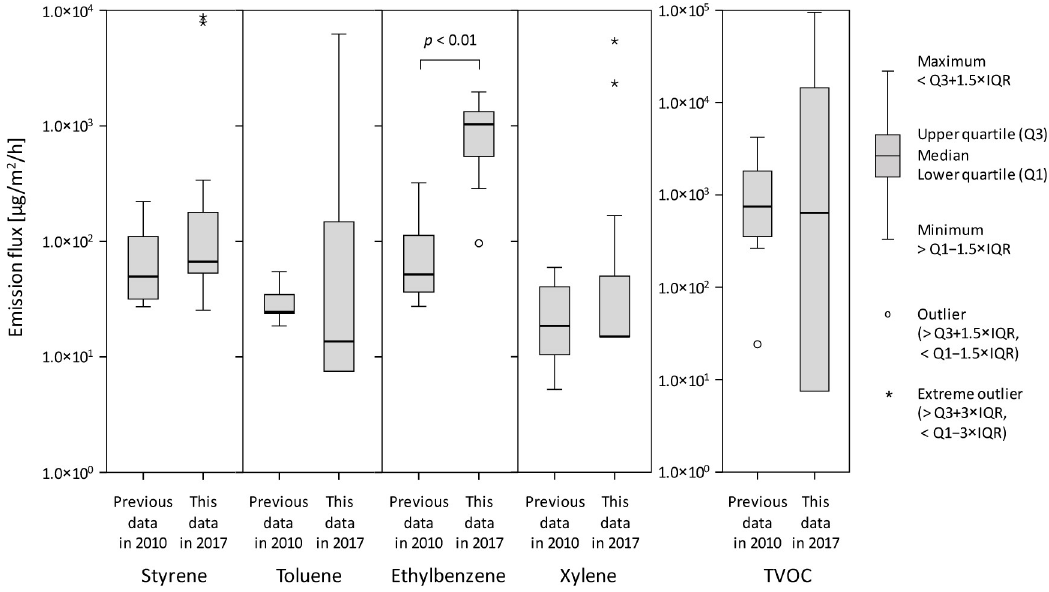
Fig 2. Styrene, toluene, ethylbenzene, xylene, and Total Volatile Organic Compound (TVOC) emission fluxes at 25˚C found in this study (performed in 2017) and in a previous study. IQR means the interquartile